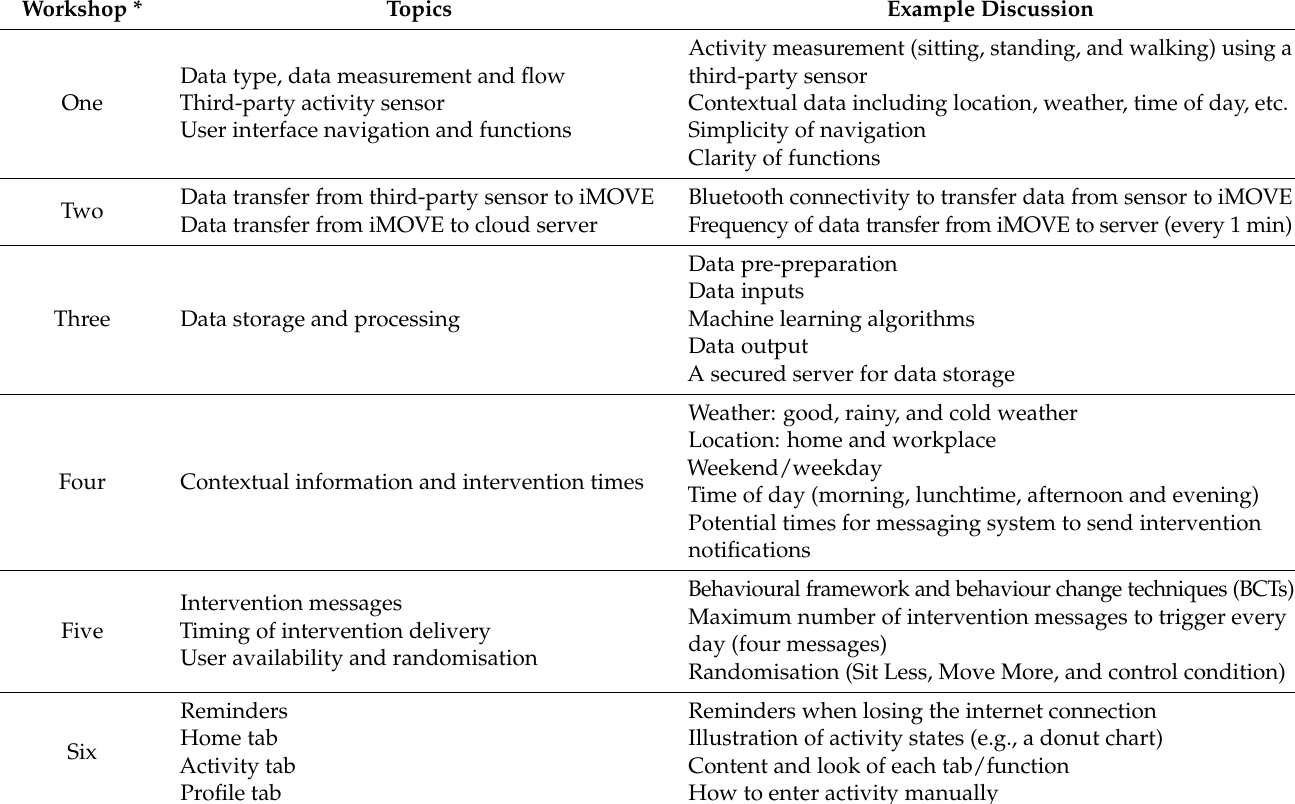
Table 1. Overview of the workshops to develop